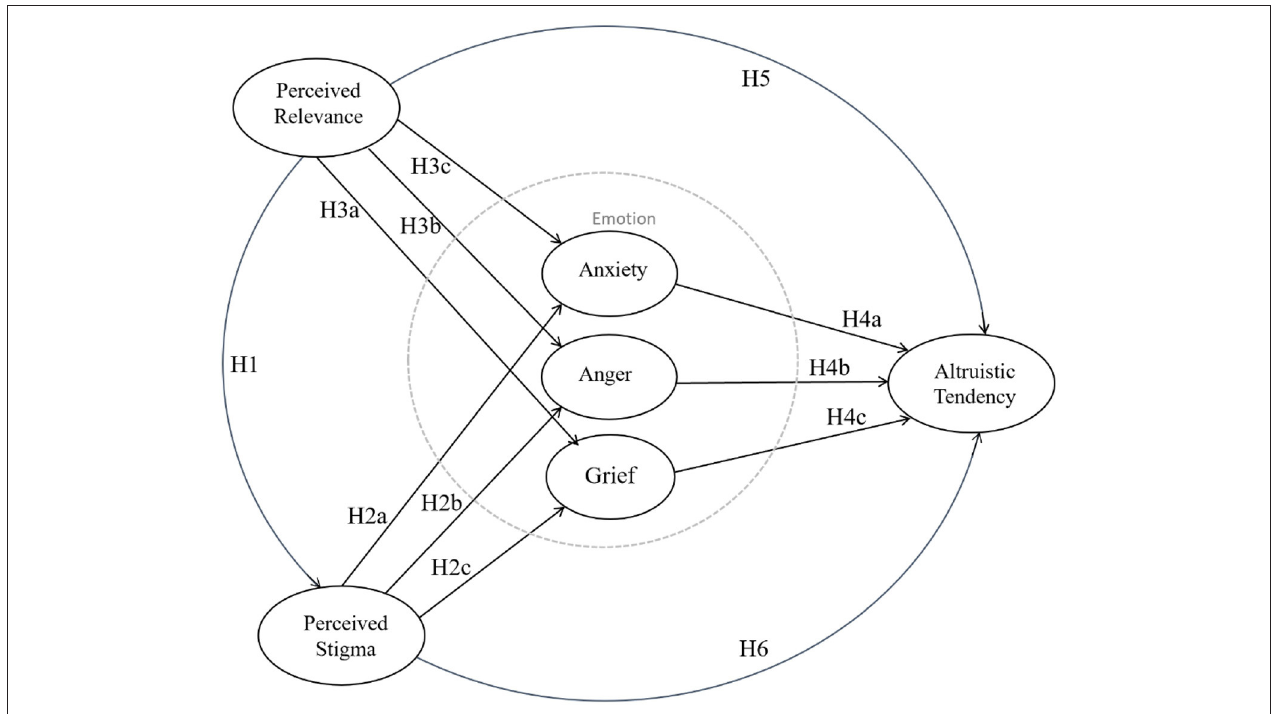
FIGURE 1 | Research